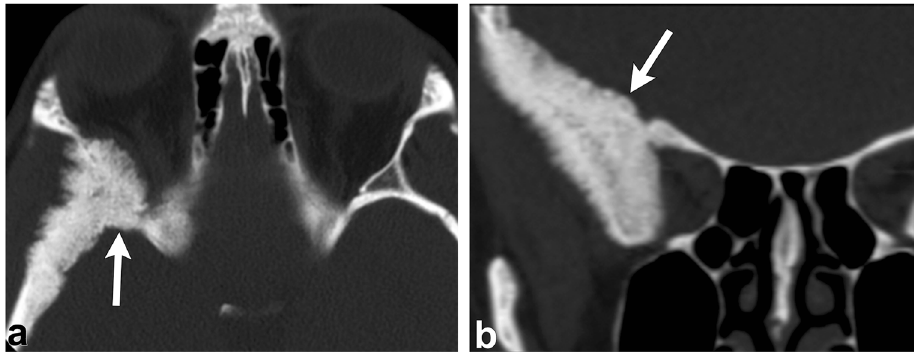
Fig. 9 Intraosseous meningioma. Axial ( a ) and coronal ( b ) CT images portray an intraosseous meningioma in the right sphenoid extending into the right lateral orbital wall ( arrows ). Note the expansion of bone and B prickly ^ border of the